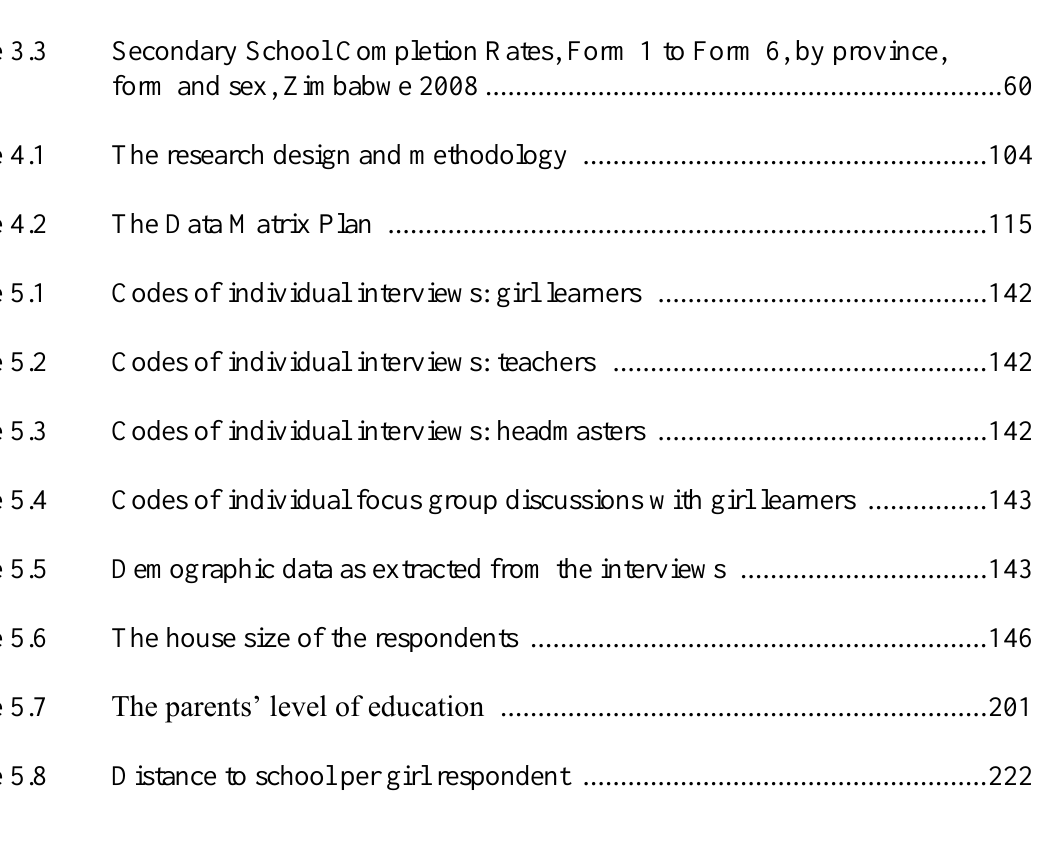
Table 3.1 Secondary School Completion Rates, Form 1 to Form 4, by sex and Table 3.2 Secondary School Completion Rates, Form 1 to Form 6, by sex and parity index, Table 3.3 Secondary School Completion Rates, Form 1 to Form 6, by province, Table 4.1